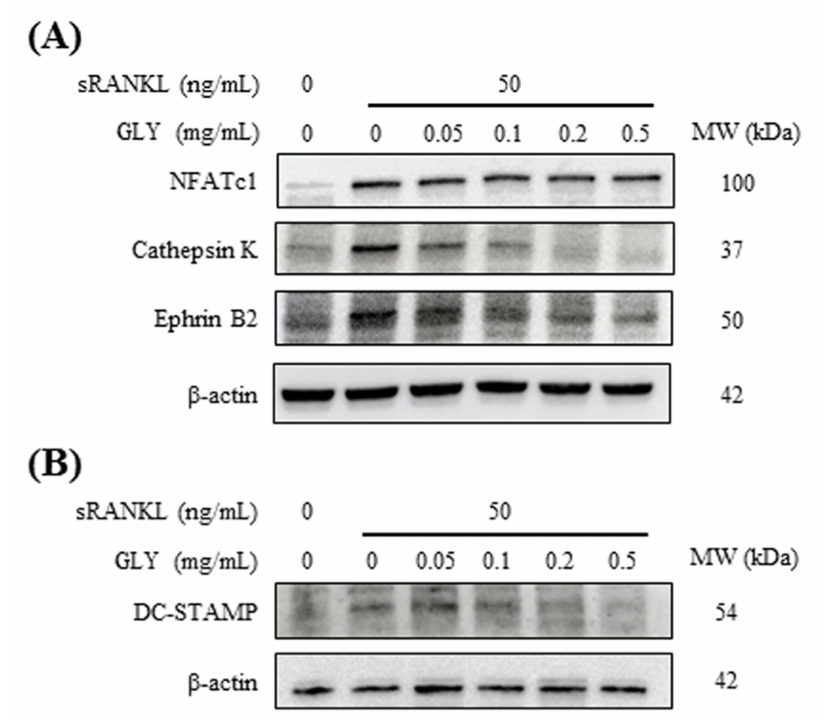
Figure 3. Effects of GLY extracts on the expression of osteoclast-specific markers in RAW264.7 cells. ( A ) sRANKL-treated RAW264.7 cells were incubated in the absence or presence of various concentrations (0.05, 0.1, 0.2 and 0.5 mg/mL) of GLY extracts for five days. The expression of NFATc1, cathepsin K and ephrin B2 in the cells were evaluated using Western blot analysis. B-actin served as a loading control. ( B ) The expression of DC-STAMP and β -actin in the cells were evaluated using Western blot